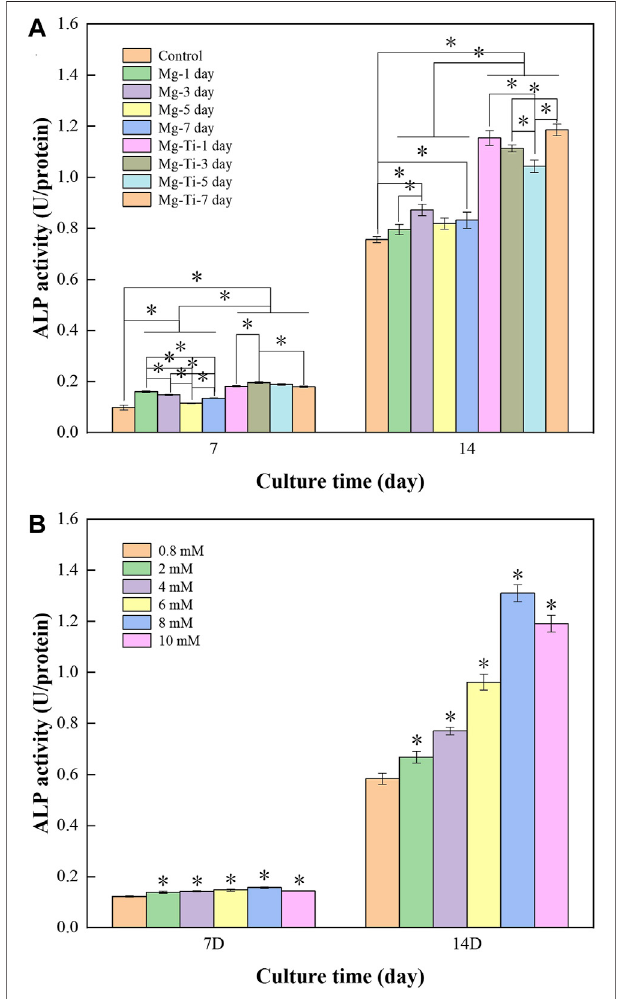
FIGURE12|(A) ALPactivityofMC3T3-E1cellsculturedwithextractsof the degraded Mg-Ti composite and pure Mg for 7 and 14 days (n=3 and * p < 0.05). (B) ALP activity of MC3T3-E1 cells cultured with gradient Mg 2+ concentrations for 7 and 14 days (n=3 and * p <